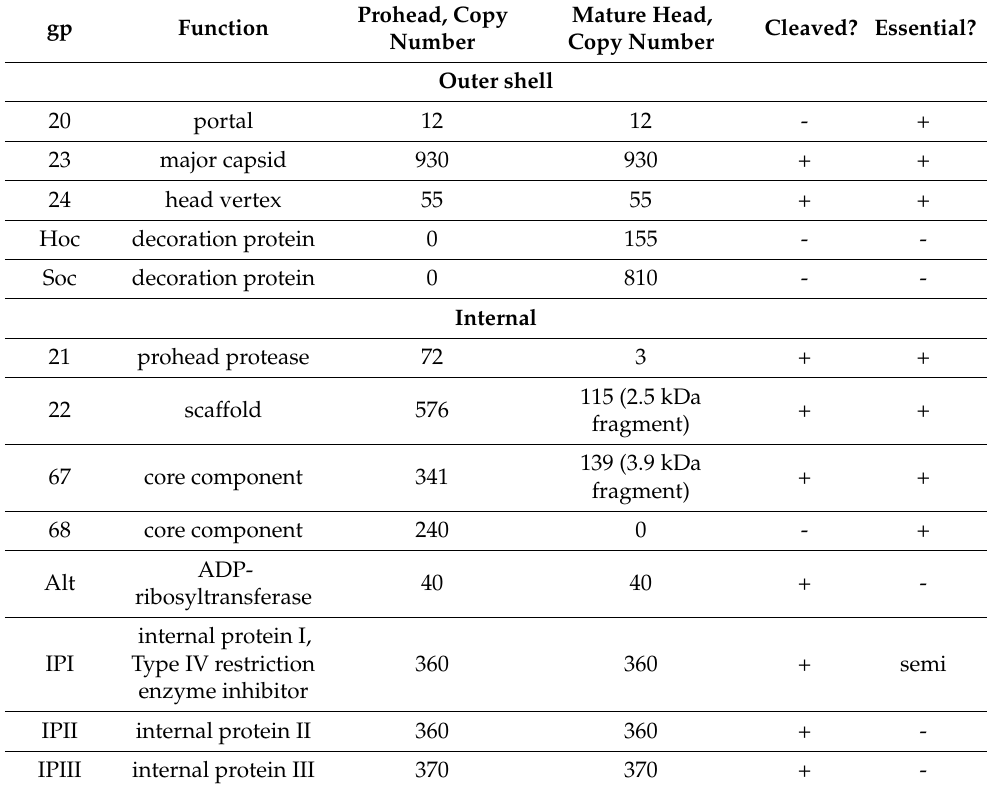
Table 1. Composition of the T4 prohead and head (adapted from Black, Showe and Steven [4] and Rao and Black